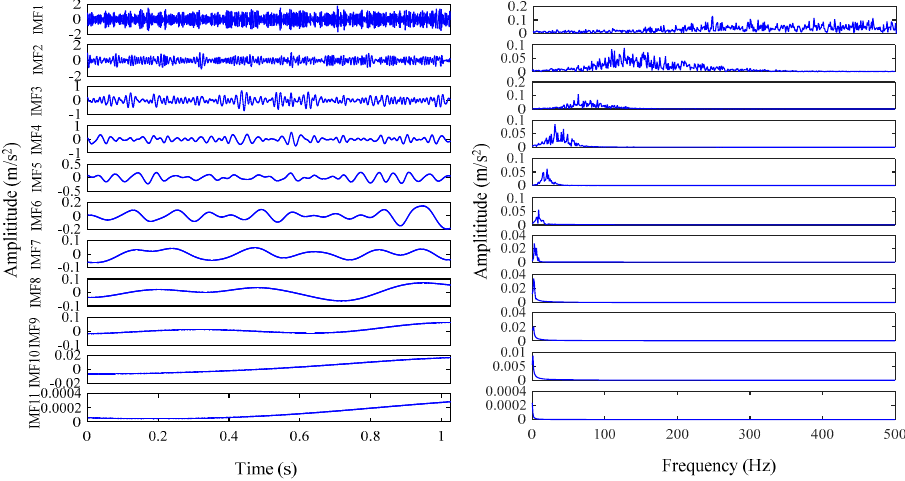
Figure 4. Decomposition results and corresponding frequency spectrum of intrinsic mode functions (IMFs) with Empiri- cal Mode Decomposition (EMD).